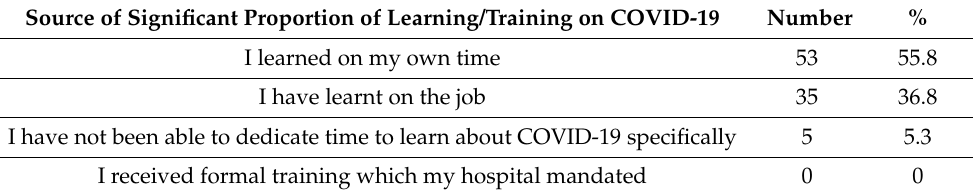
Table 7. Opportunity for additional learning undertaken during the COVID-19 Pandemic ( n = 95). Source of Significant Proportion of Learning/Training on